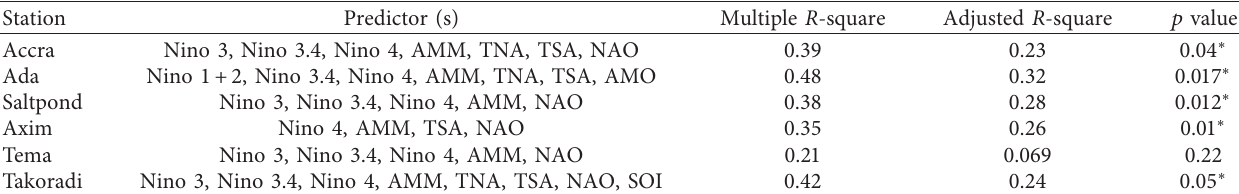
Table 6: Summary of stepwise regression results between DJF SPI and NDJ climate indices. Station Predictor